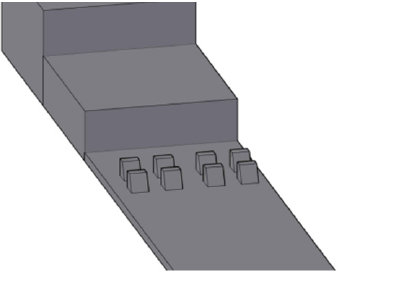
Figure 2. Schematic diagram of the arrangement of energy dissipation pier. ( a ) Double-row arrange- ment, ( b ) staggered arrangement, and ( c ) traditional steps.